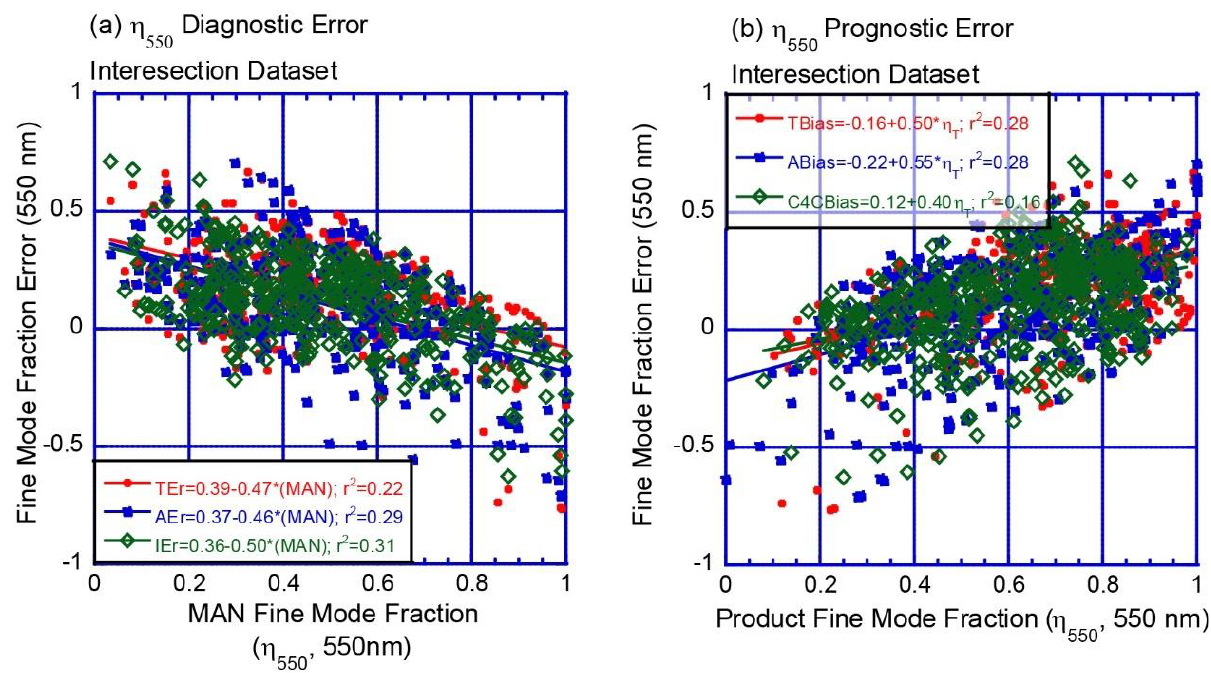
Figure 10. Scatter plots of fine mode fraction ( η 550 ) error. ( a ) Diagnostic error of Terra MODIS, Aqua MODIS, and the ICAP C4C against SDA-derived vales from MAN. ( b ) Prognostic error of calculated η 550 error against MAN as a function of the η 550 values provided by Aqua MODIS.